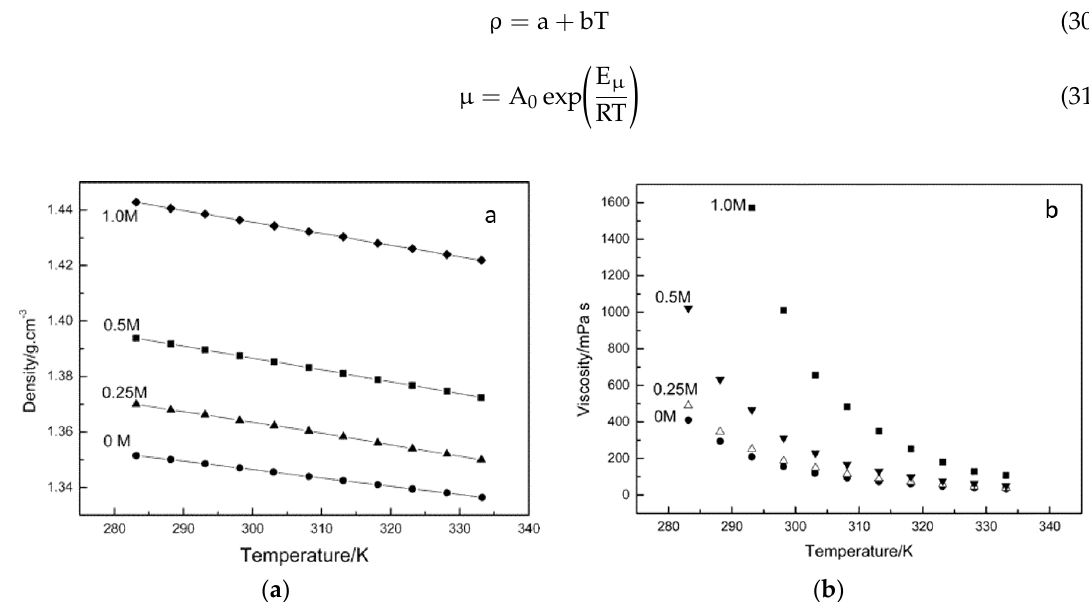
Figure 5. ( a ) Variation in solution density, and ( b ) solution viscosity with temperature for TMHA-TFSI ionic liquid containing different concentrations of LiTFSI salt [53].